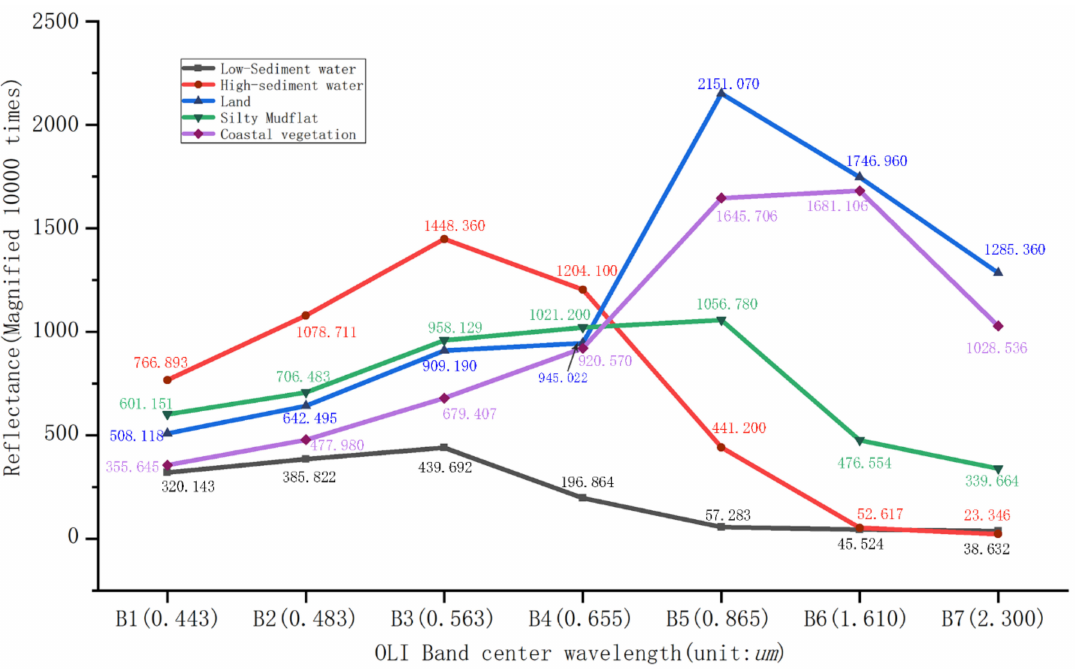
Figure 2. Average spectral reflectance of typical features in the study